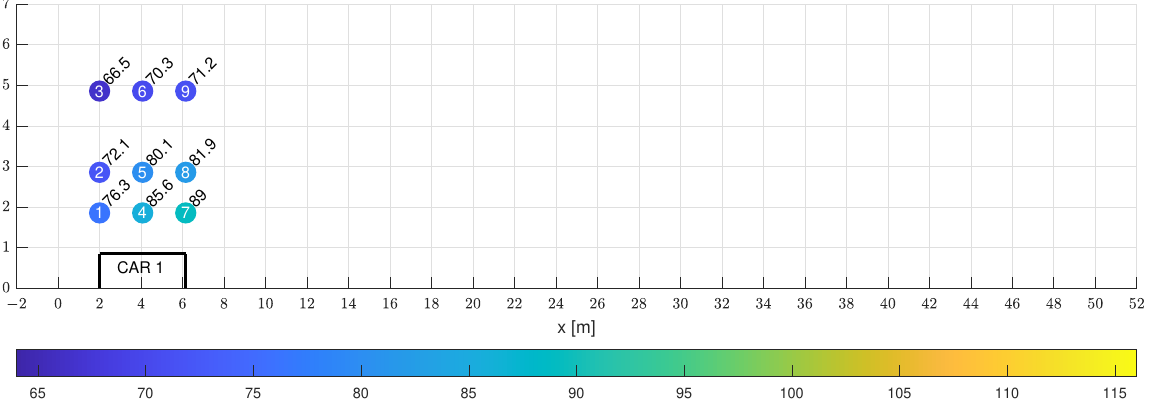
Figure 15. Overall sound pressure level in decibels (dB) on the side of the single car, measured at receivers for the z-coordinate of 1.7 m. View from the top.